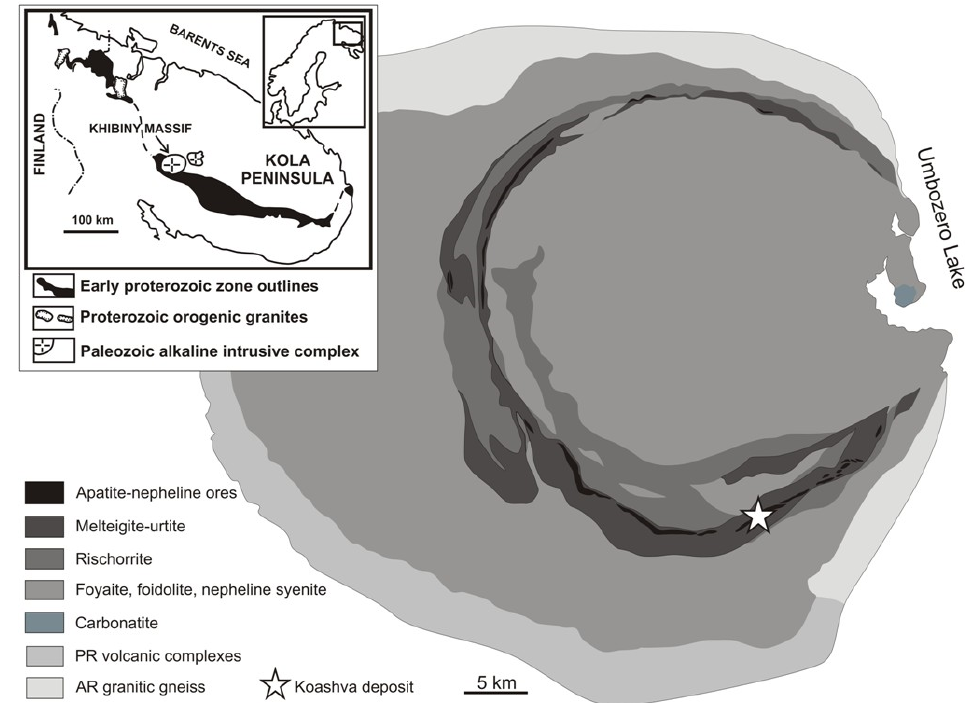
Figure 1. Geology map of the Khibiny massif (modified from [1]).